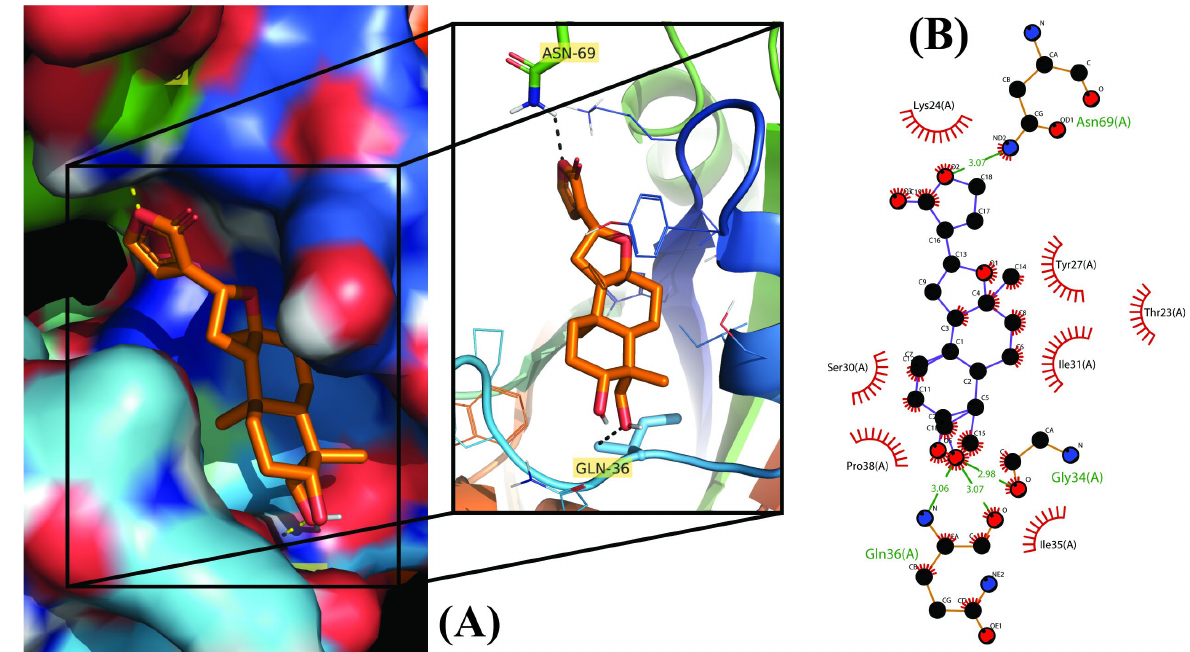
Figure 4. Molecular docking results of Isoandrographolide into the catalytic domain of diphtheria toxin. ( A ) Three-dimensional binding mode of Isoandrographolide in the protein active site. ( B ) Two-dimensional interactions showing amino acid residues involved in hydrogen bonding, salt-bridge, and hydrophobic interactions.